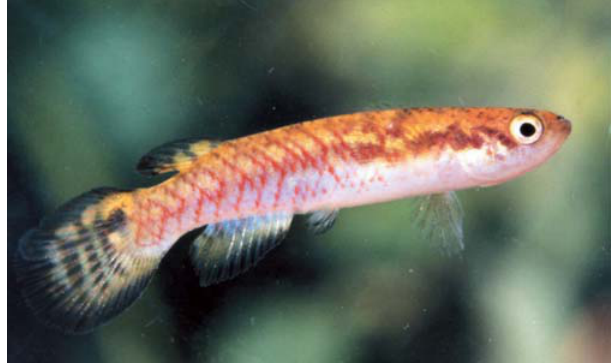
Fig. 7. Rivulus litteratus , UFRJ 5957, female, paratype, 25.6 mm SL (one day after collection); Brazil: Mato Grosso: